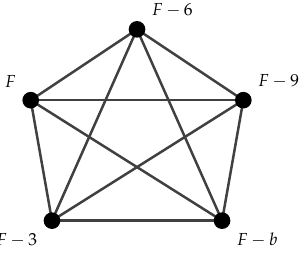
Figure 1. Minimum possible clique for the case m = 3.